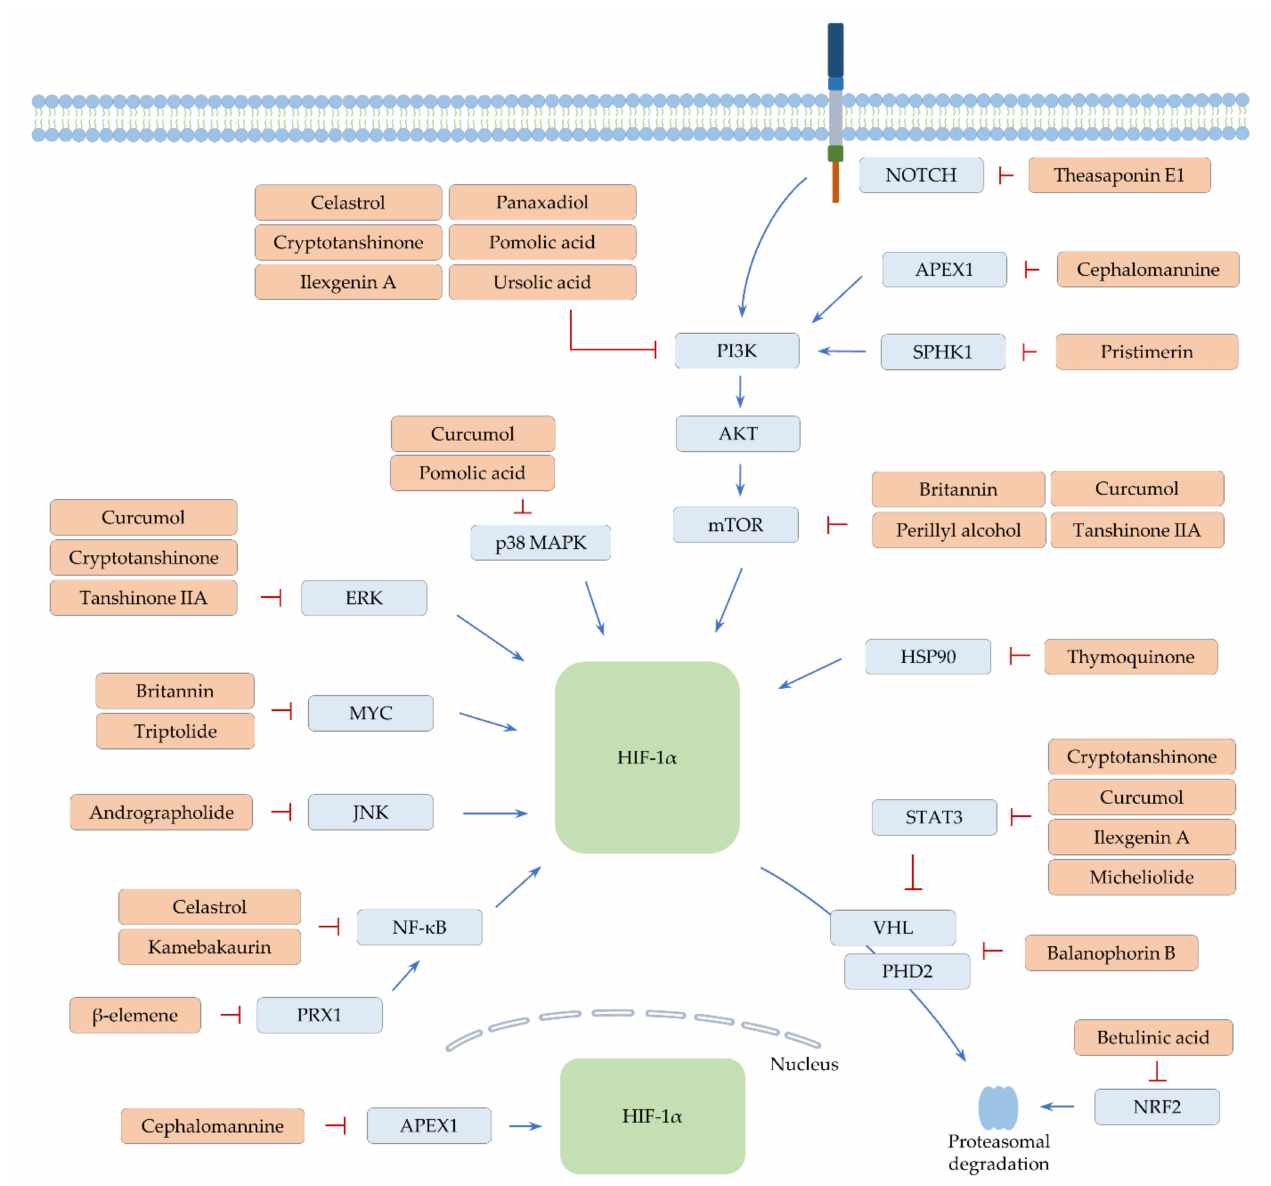
Figure 3. Proposed mechanisms by which terpenes regulate HIF-1 α . Positive modulation is denoted by arrow lines (blue). Perpendicular lines designate an inhibitory effect